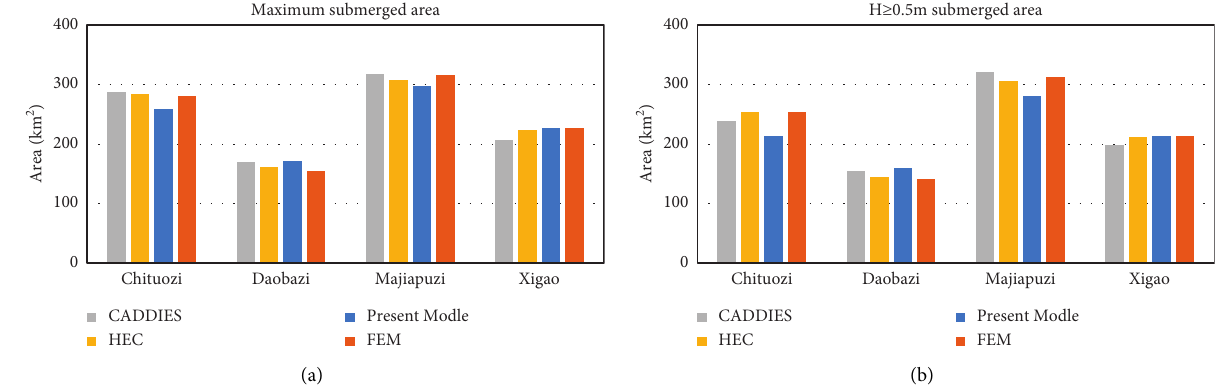
Figure 8: Comparison of the submerged areas in four scenarios for the different flood models.